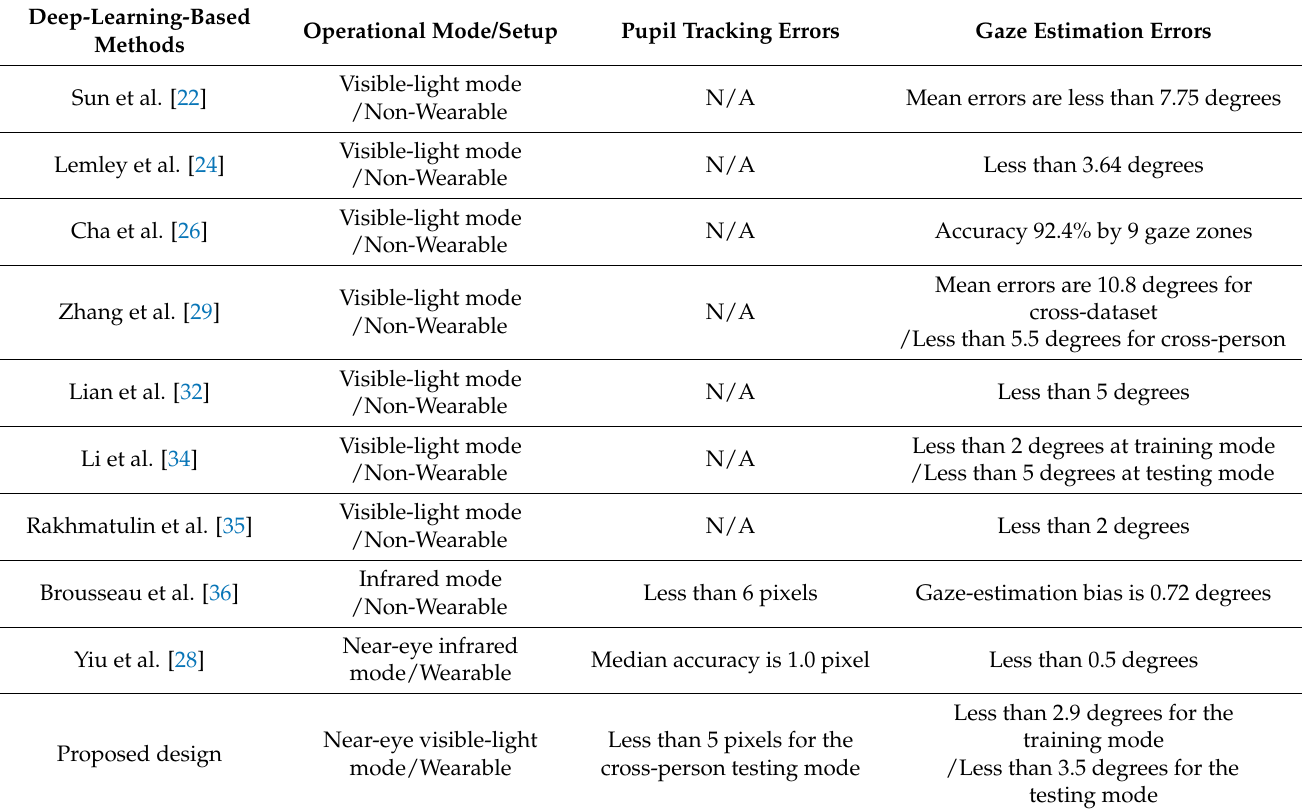
Table 10. Performance comparison of the deep-learning-based gaze tracking designs.